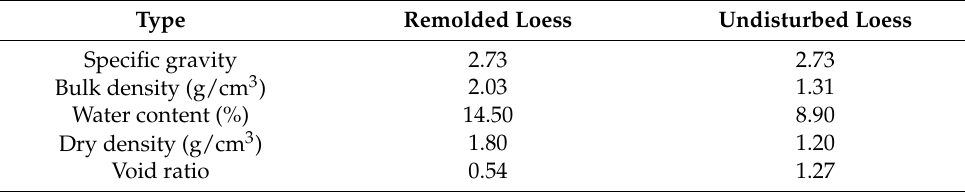
Table 3. The basic parameters of the loess in the study area measured by laboratory